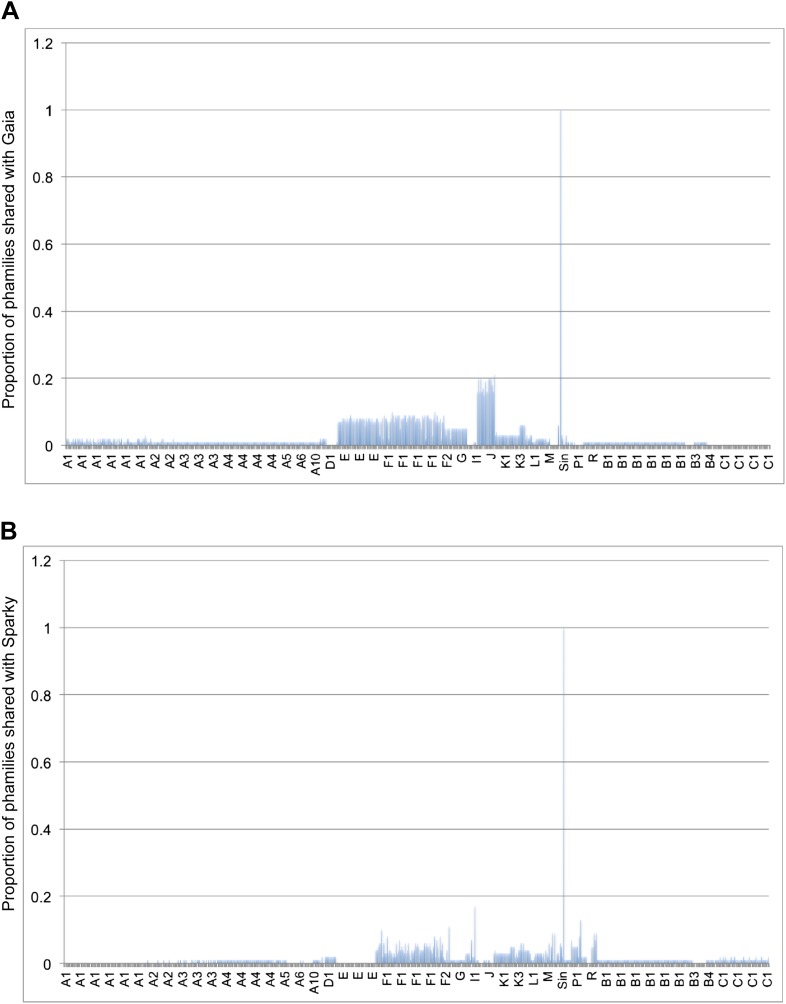
Shared gene content between Gaia, Sparky, and other mycobacteriophages.(A) Average percentages of phamilies shared between Gaia and other mycobacteriophages. (B) Average percentages of phamilies shared between Sparky and other mycobacteriophages. Genomes on the x axis are listed in the same order as in Supplementary file 1 and the cluster designations are indicated.